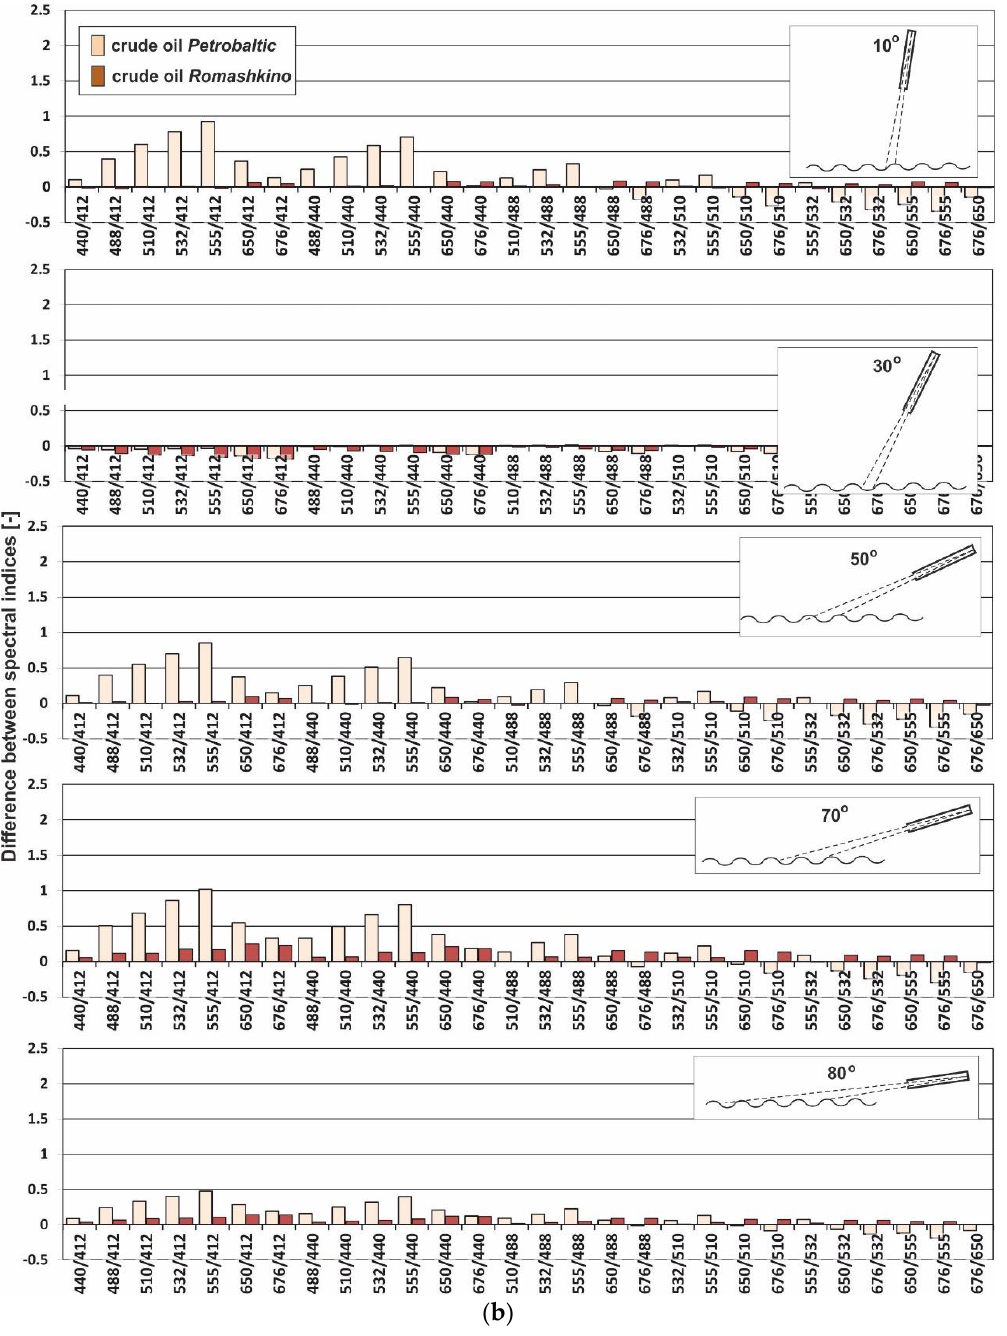
Figure 3 ( a ) Differences between spectral indices of water contaminated by dispersed oil, and indices of oil-free water, determined at chosen viewing angles measured from the solar light side (−80°, −70°, −50°, −30°, and −10°, respectively), for roughened sea surface with a 2 m/s wind speed. The green rectangle on the bottom chart indicates an optimal for the analyzed case viewing angle and wavelength combination for the spectral index. ( b ) Differences between spectral indices of water contaminated by dispersed oil and indices of oil-free water, determined at chosen viewing angles measured on the opposite of solar light side (10°, 30°, 50°, 70°, and 80°, respectively), for roughened sea surface with a 2 m/s wind speed.